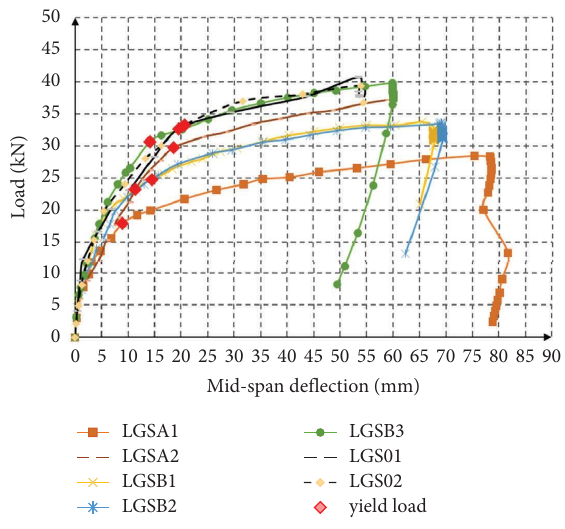
Figure 12: Load-defection curve.